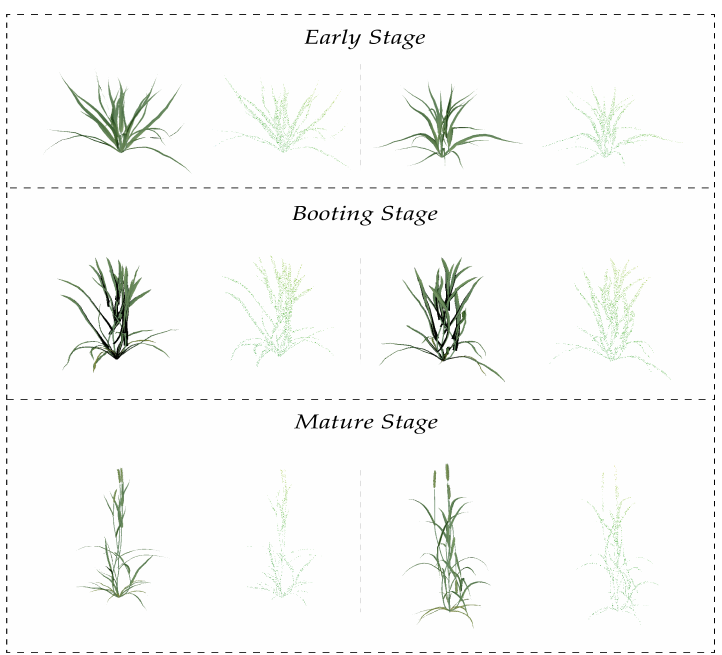
Figure 7. According to the wheat images of different stages, the corresponding 3D point cloud is reconstructed by the trained